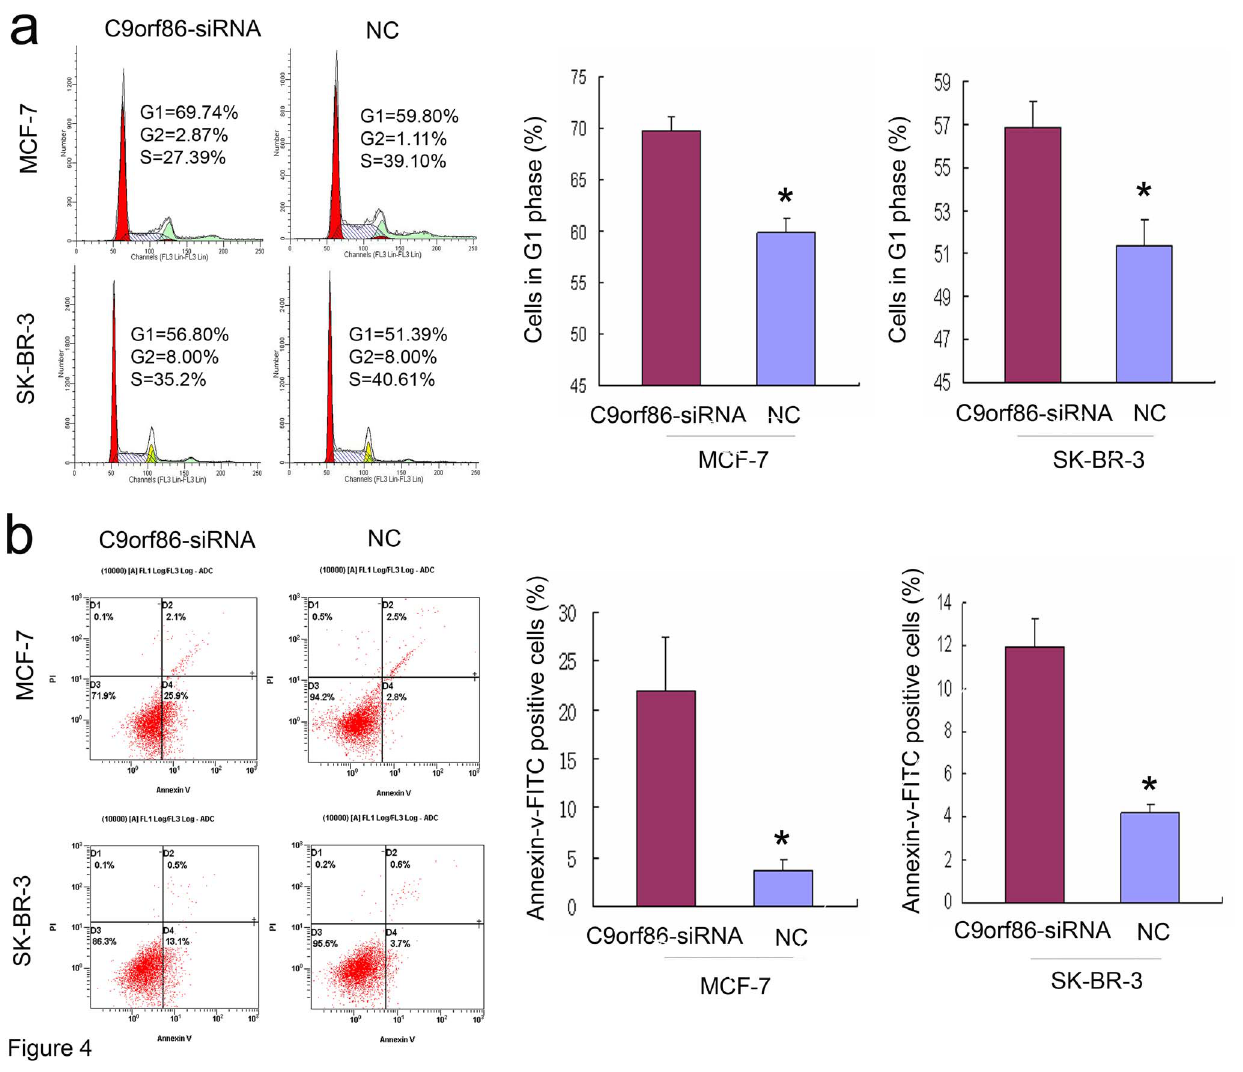
Figure 5. Silencing of C9orf86 expression inhibits invasion ability of MCF-7 cells and SK-BR-3 cells. Cell invasion was assayed in a transwell coated with Matrigel. Cells that crossed the Matrigel-coated filter were fixed, stained, and counted. Six random microscopic fields were counted for each group. The results presented are an average of six random microscopic fields from three independent experiments. Significant reduction of invasion was observed after silencing C9orf86 expression in MCF-7 cells and SK-BR-3 cells. *P , 0.05. NC, negative